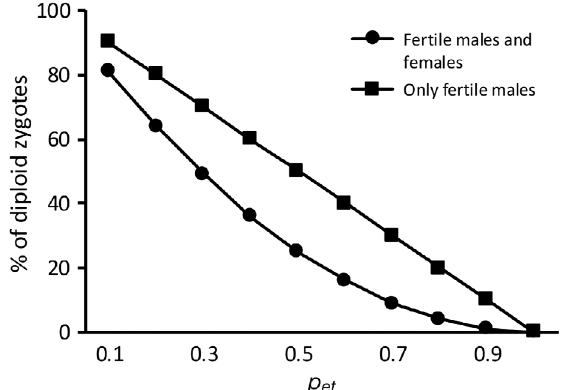
Fig. 2. Expected frequency of di ploids, aneuploids, triploids Fig. 3. Proportion of diploid zygotes produced in a mixed and tetraploid zygotes of a species with n = 10 as a function population of diploid and triploid brooders with one or both of the relative contribution of triploids ( p et ). Fertilization is triploid sexes fertile, as a function of the relative contribu- tion of triploids ( p et ) assumed to be random, with equal fecundity for both kinds of karyotype